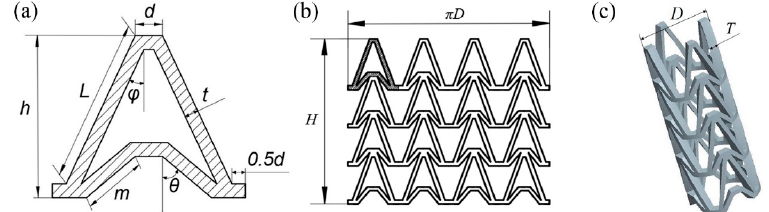
Figure 1. Vascular stent model with NPR structure, ( a ) Arrowhead NPR structure unit; ( b ) Stent flat developing drawing; ( c ) Three-dimensional model of stent.